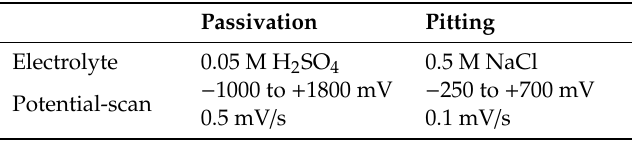
Table 3. Parameters of the conducted corrosion tests.